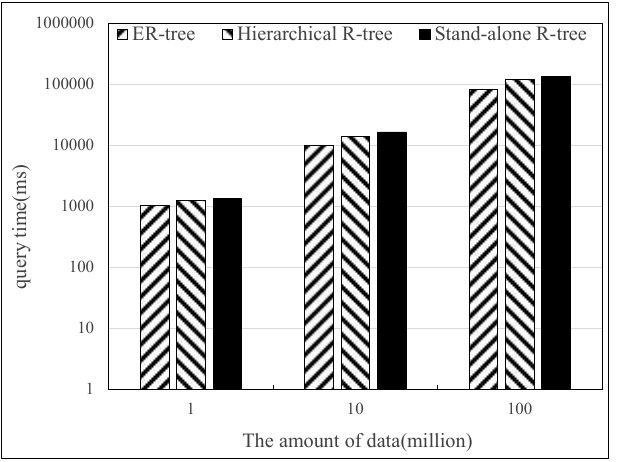
Figure 14. Comparison of the index circle query performance on the simulated dataset. Real dataset point query: In this paper, we randomly selected a query point on the real dataset for querying and repeated the above operation 1000 times to calculate the average query time. The experimental results are shown in Figure 15. The ER-tree index shows better point query performance on both real datasets, indicating that the index design in this paper is effective.